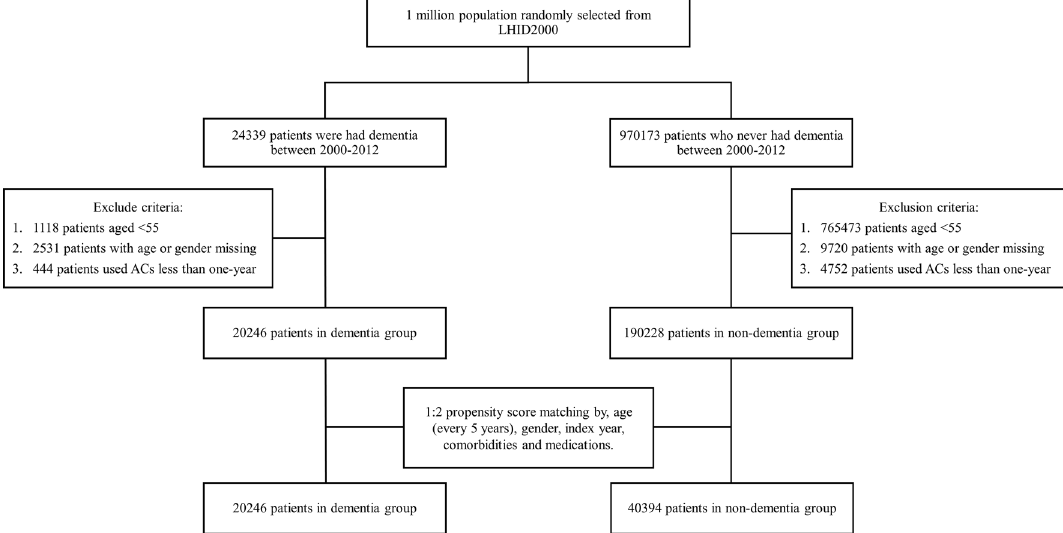
Figure 1. Flow chart for establishing antimuscarinic use and comparison cohorts using the National Health Insurance Research Database